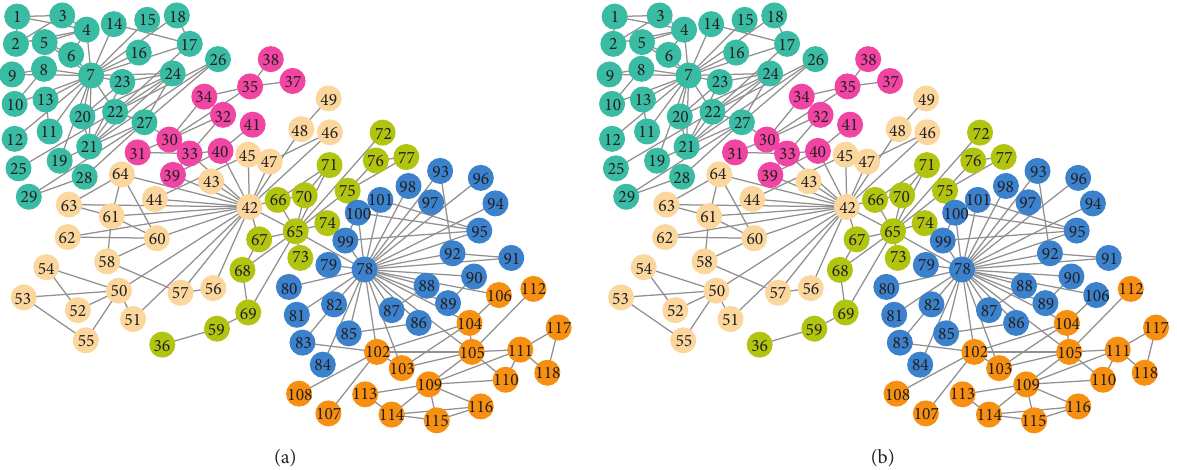
Figure 9: The scientists’ collaboration network: (a) the ground-truth community structure; (b) the community structure revealed by the proposed method.